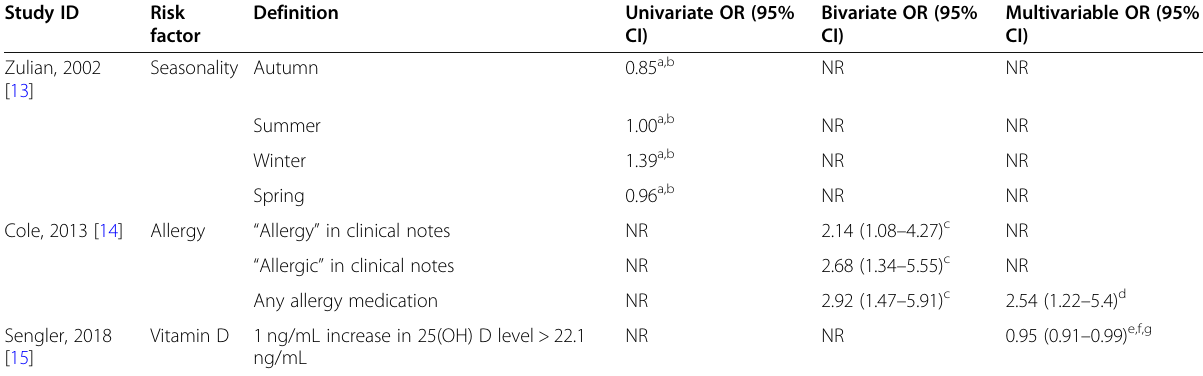
Table 5 Risk factors associated with JIA-U. a reported point estimate, b confidence intervals not reported, p-value > 0.05, c adjusted for race and gender, d adjusted for race, gender, age, oligo subtype, ANA, RF, psoriasis, e reported as HR, f adjusted for MTX and uveitis risk factors (age of JIA onset, female sex, oligoarticular JIA and ANA positivity), g when analysed by patients who were sampled prior to uveitis diagnosis the results were HR 0.95, 95% CI 0.92 – 1.00. ANA, anti-nuclear antibody; CI, Confidence interval; HR, hazard ratio; MTX, methotrexate; NR, not reported; OR, odds ratio; RF, rheumatoid factor; 25(OH) D, 25-hydroxyvitamin